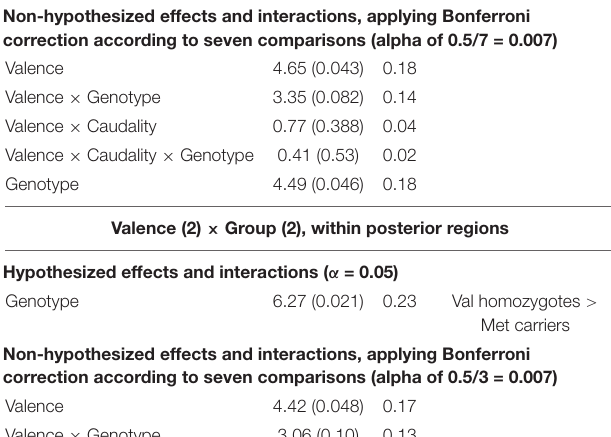
TABLE 5 | Experiment 2: Results of mixed factorial ANOVA of old-new difference scores with factors of. Valence (2) × Caudality (2) × Genotype (2) Contrast F ( p ) η 2 p Direction (significant main effects only) Hypothesized effects and interactions ( α =